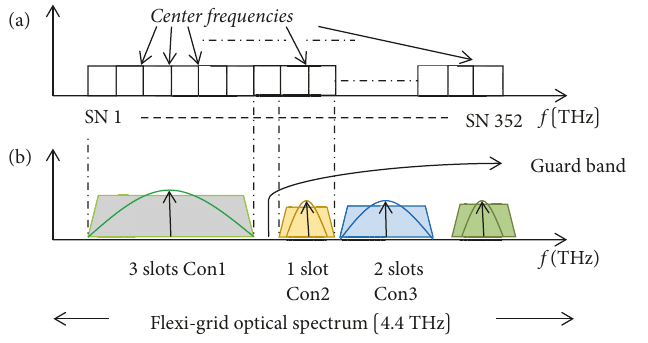
Figure 3: Slots in a Flexi-grid network: (a) slots in flexi-grid frequency spectrum have a nominal center frequency granularity of 6.25 GHz, with the slot width of 12.5 GHz; (b) connections 1, 2 and 3 with even number of slots around a center frequency and a guard band between connections 1 and 2.